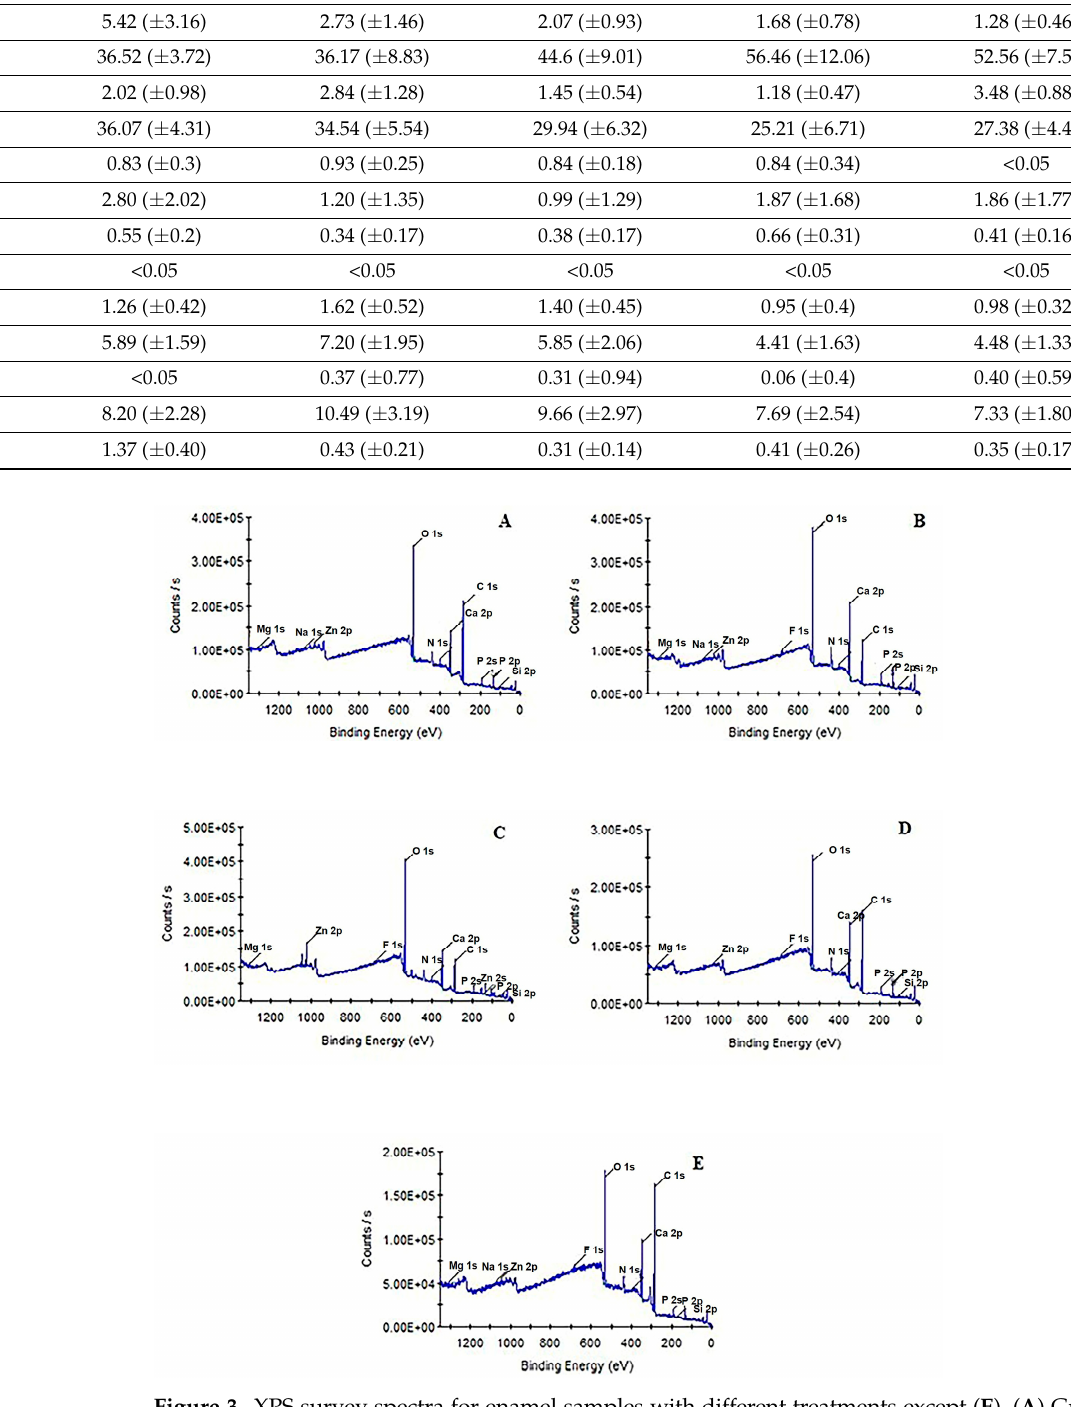
Figure 3. XPS survey spectra for enamel samples with different treatments except ( E ). ( A ) Group 1: